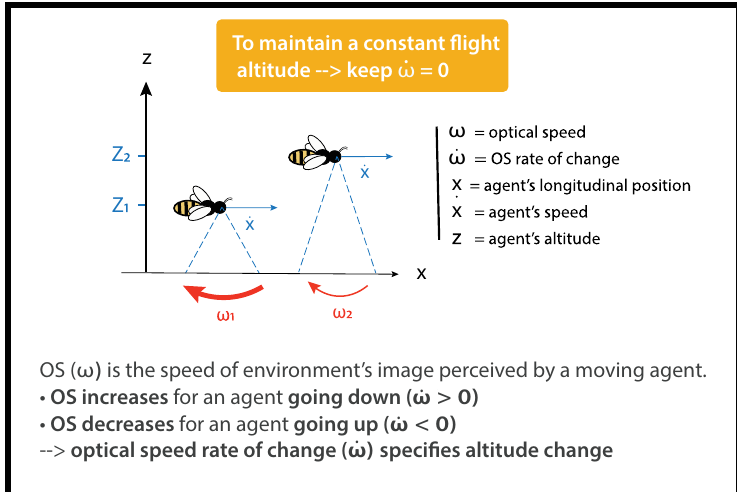
Figure 1. Optical speed (OS) and its rate of change